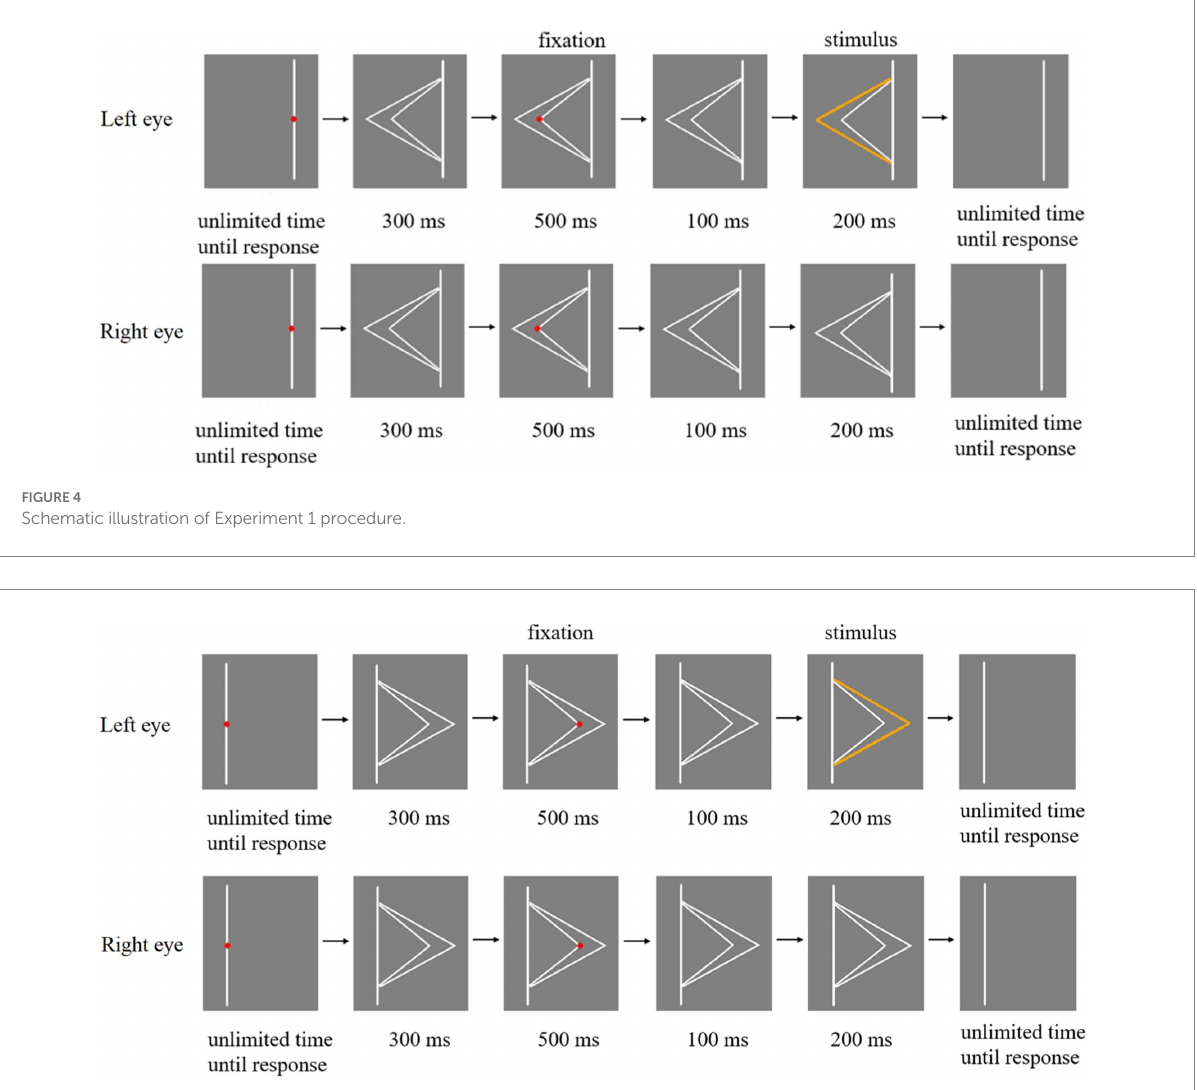
FIGURE 5 Flow chart of a trial in Experiment